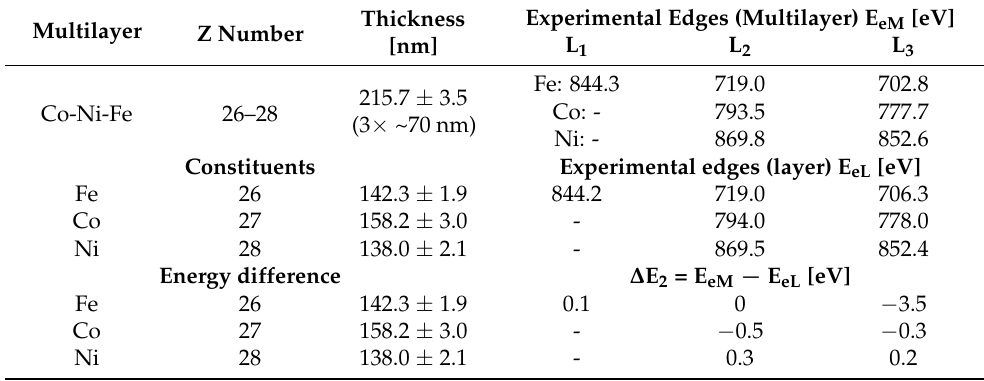
Table 3. Co-Ni-Fe multilayer sample. The results of L 1–3 edge NEXAFS experimentally obtained energies for multilayer and single layers of constituent materials. Experimentally obtained edge energies are slightly shifted comparing single metal layer and multilayer, where ∆ E = E eM − E eL